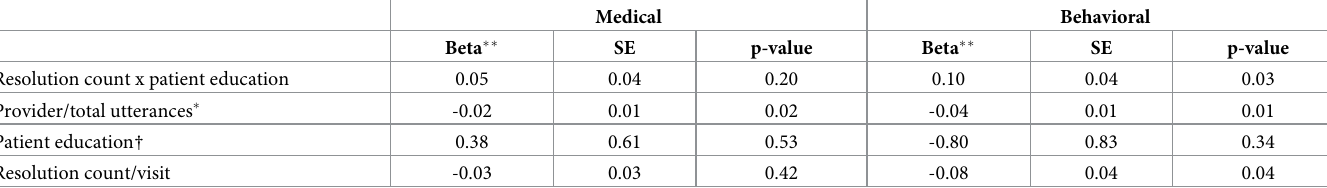
Table 3. Multivariable ordered logit model predicting patient